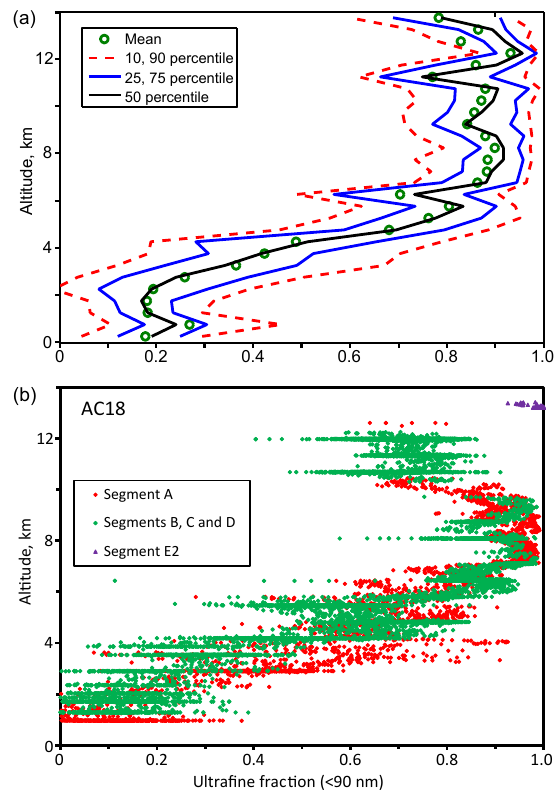
Figure 10. Vertical profiles of the ultrafine fraction (UFF); (a) over- all statistics from all flights, (b) examples from individual profiles on flight